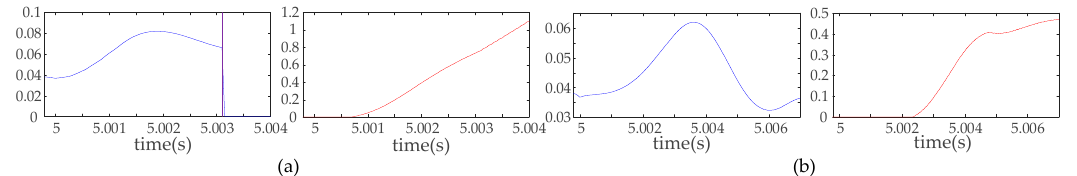
Figure 12. External pole-to-pole fault for Photovoltaic (PV) protection.